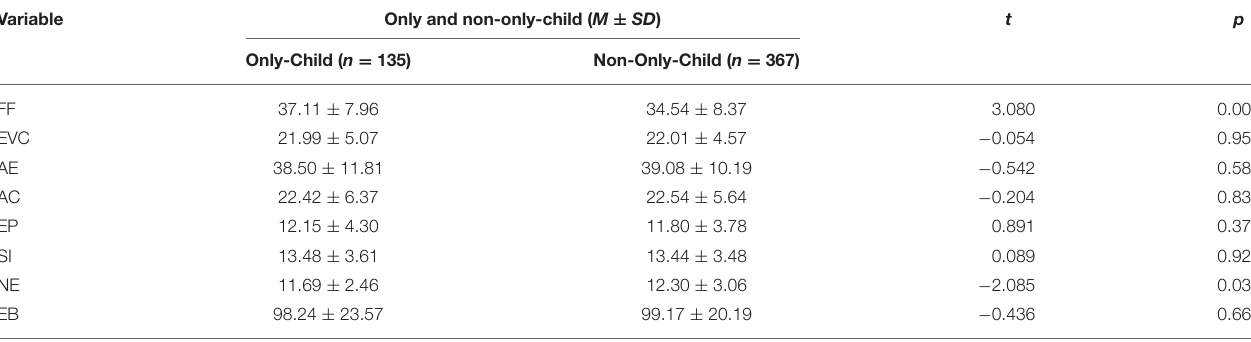
TABLE 1 | Differences in FF, exercise behavior, and exercise value cognition. Variable